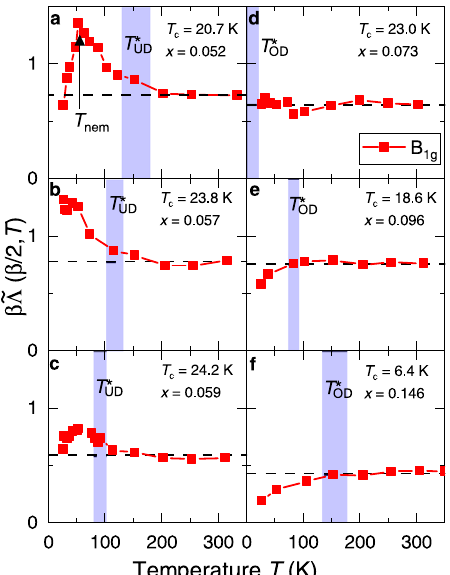
Fig. 2 Transformation onto the imaginary time axis. Shown is β ~ Λ ð β = 2 Þ , the imaginary time-ordered correlation function ~ Λ ð τ Þ derived from the Raman spectra of Ba(Fe 1 − x Co x ) 2 As 2 and evaluated at τ = β /2 multiplied by the inverse temperature β = 1/ k B T , versus temperature T . The dashed lines correspond to β ~ Λ ð β = 2 ; T Þ ¼ const, and the blue regions indicate the deviation from this constant behavior, which we use to de fi ne the crossover temperatures T (cid:3) and T (cid:3) for x < x c and x > x c , respectively. a At x = 0.052 UD OD doping a nematic transition occurs at T nem ~ 50 K at which β ~ Λ ð β = 2 ; T Þ develops a cusp and then decreases toward T c . b At x = 0.057, β ~ Λ ð β = 2 ; T Þ increases toward lower temperatures and develops a maximum above T c . c Closer to the quantum critical point (QCP) β ~ Λ ð β = 2 ; T Þ develops a hump between T (cid:3) and T c . d On the overdoped side at x = 0.073 the Ω / T scaling UD persists down to T c . e Further away, the crossover temperature increases again. f The high crossover temperature at x = 14.6 coincides with a small superconducting transition temperature.